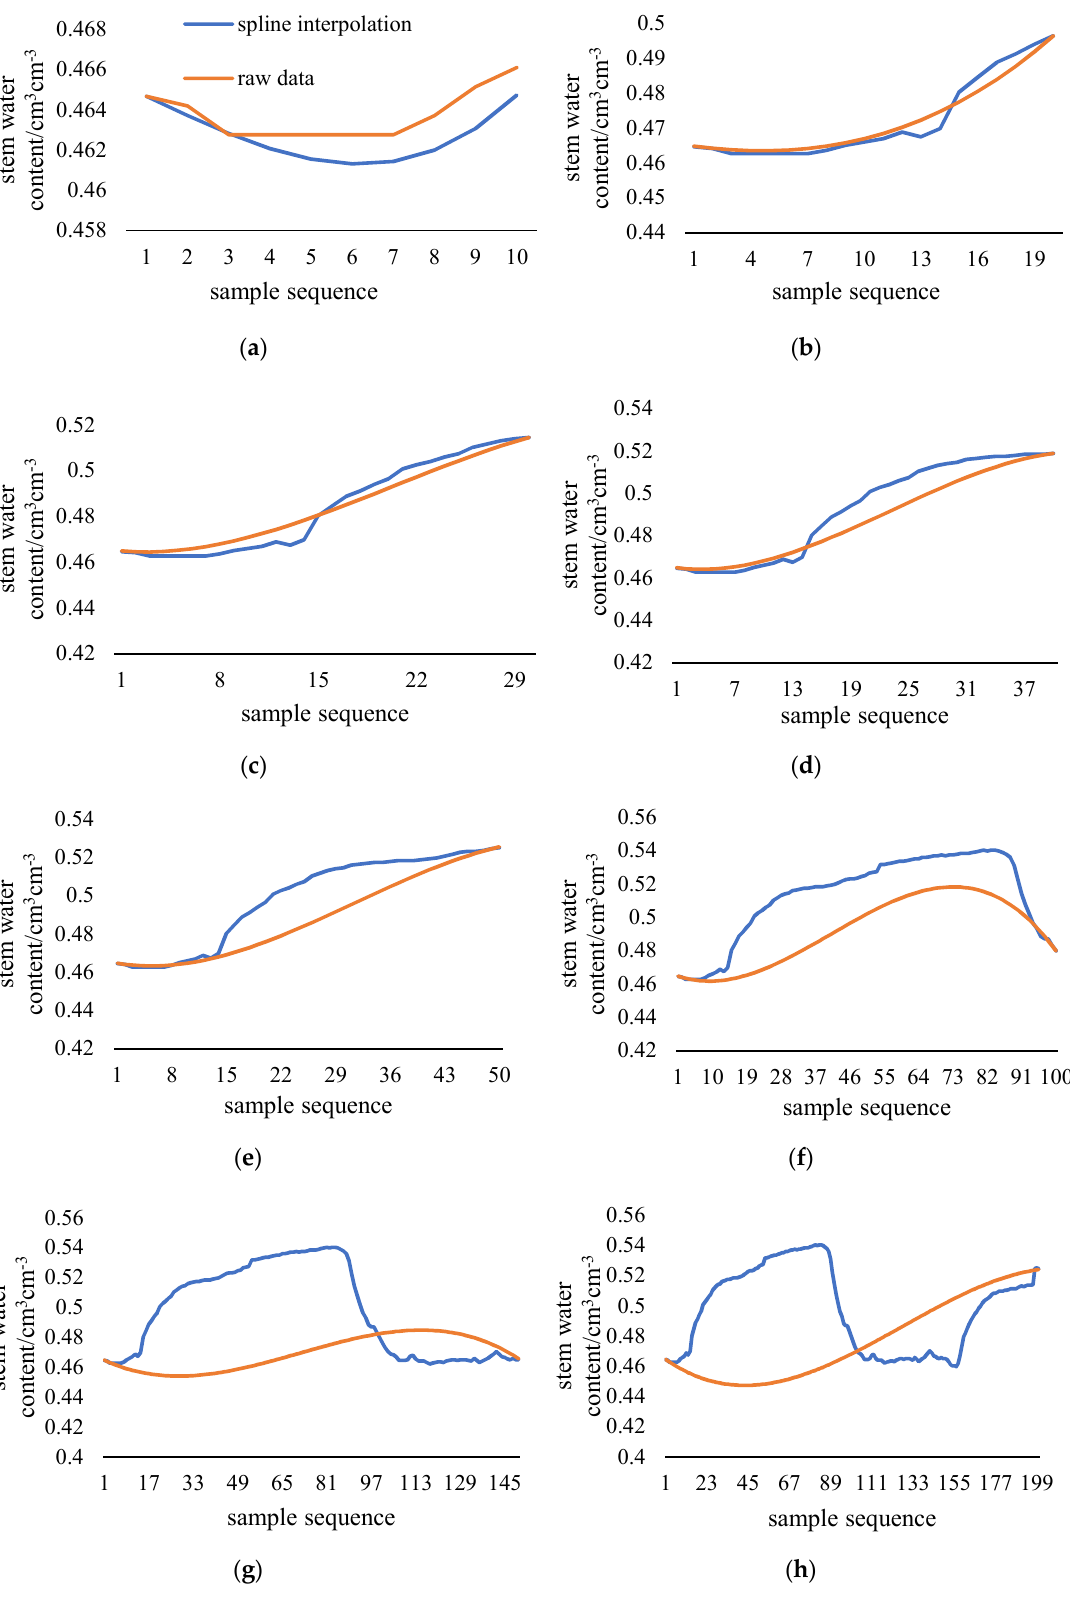
Figure 4. Interpolation filling results of different lengths. The length of filling is 10 ( a ), 20 ( b ), 30 ( c ), 40 ( d ), 50 ( e ), 100 ( f ), 150 ( g ), 200 ( h ), in this order.